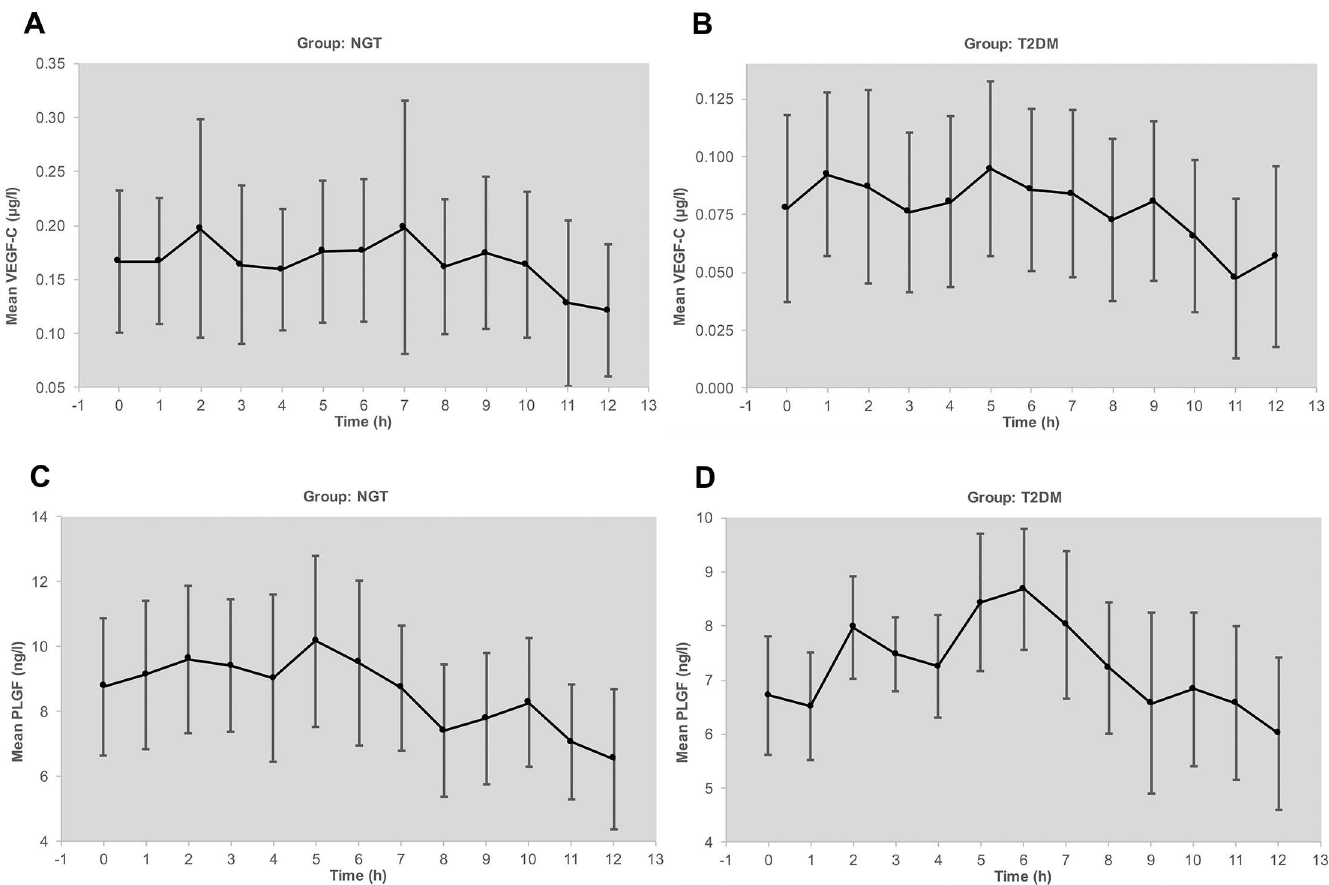
(arithmetic mean and SD) in plasma of subjects with normal glucosetolerance(NGT). D) Circadianrhythm of PLGF levels (arithmetic mean and SD) in plasma of patients with type 2 diabetesmellitus